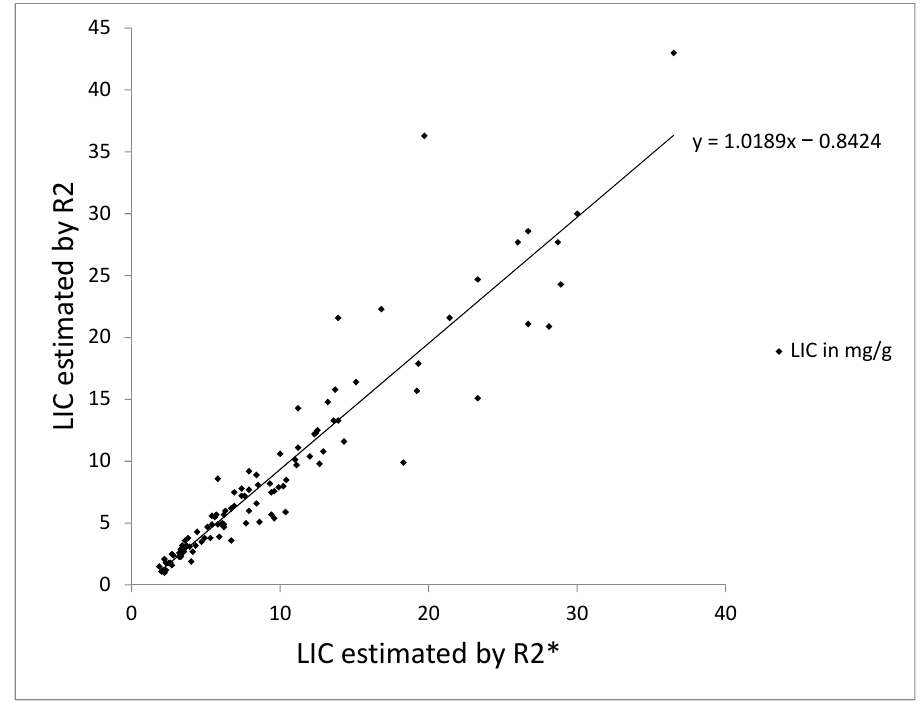
Figure 1. Scatter plot of liver iron concentration (LIC) by R2* versus LIC by R2 with linear regression line. The slope is 1.01 ± 0.03, the intercept is − 0.84 ± 0.44 and r 2 is 0.88. The correlation coefficient for R2* and R2 is 0.94.